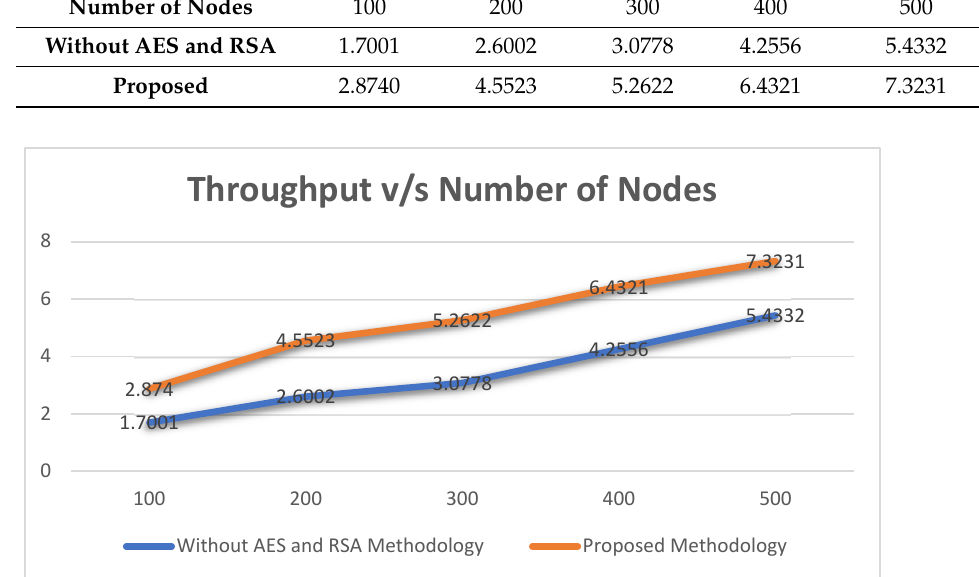
Table 2. Throughput of without AES and RSA and proposed mechanism.